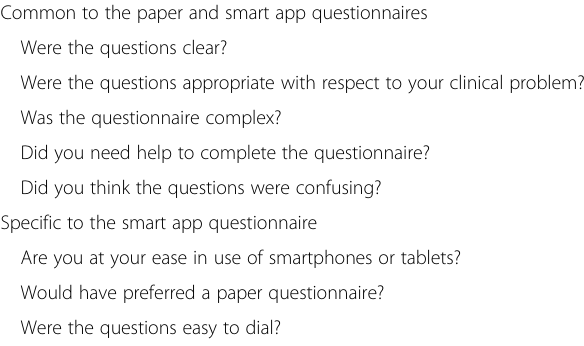
Table 1 English translation of the acceptability questionnaire Common to the paper and smart app questionnaires Were the questions clear? Were the questions appropriate with respect to your clinical